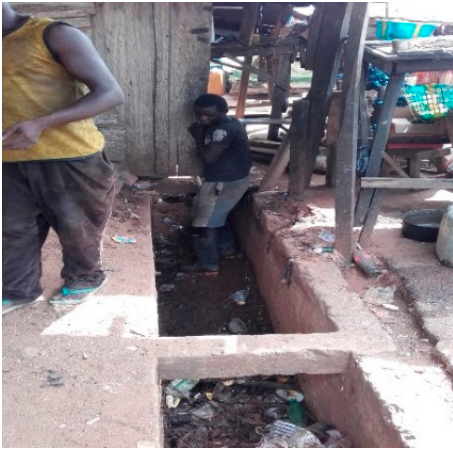
Figure 7. The hired Fulani.